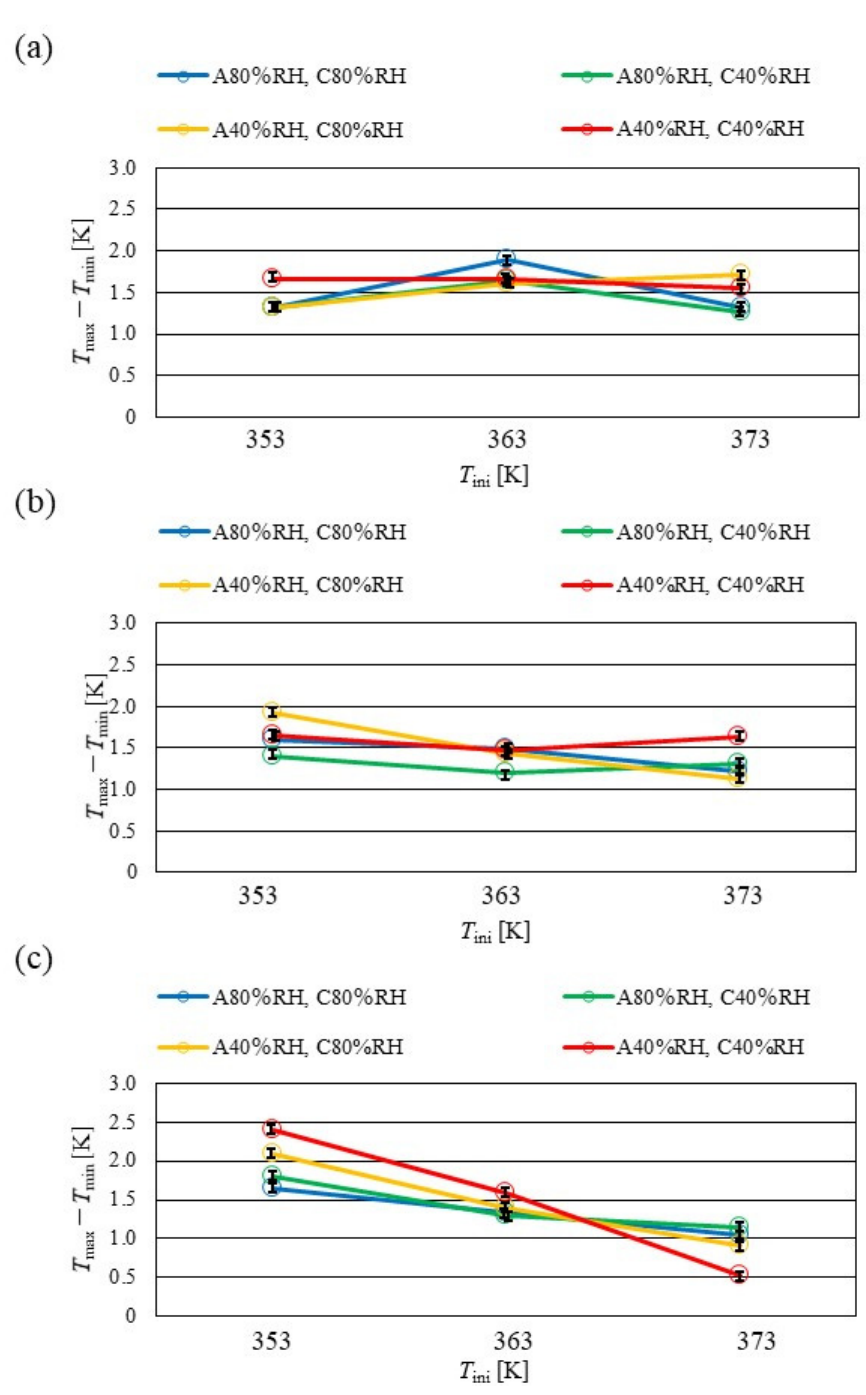
Figure 21. Comparison of relationships between the T init and temperature difference T max − T min at the cathode side among different RHs: ( a ) 2.0 mm; ( b ) 1.5 mm; ( c ) 1.0 mm.